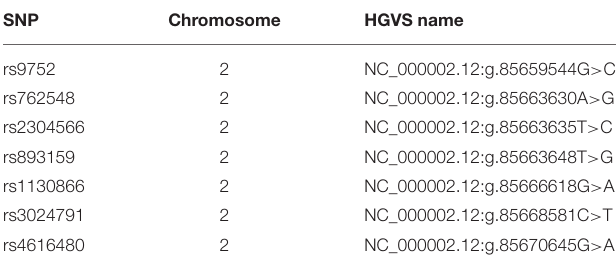
TABLE 1 | Characterization of tagged